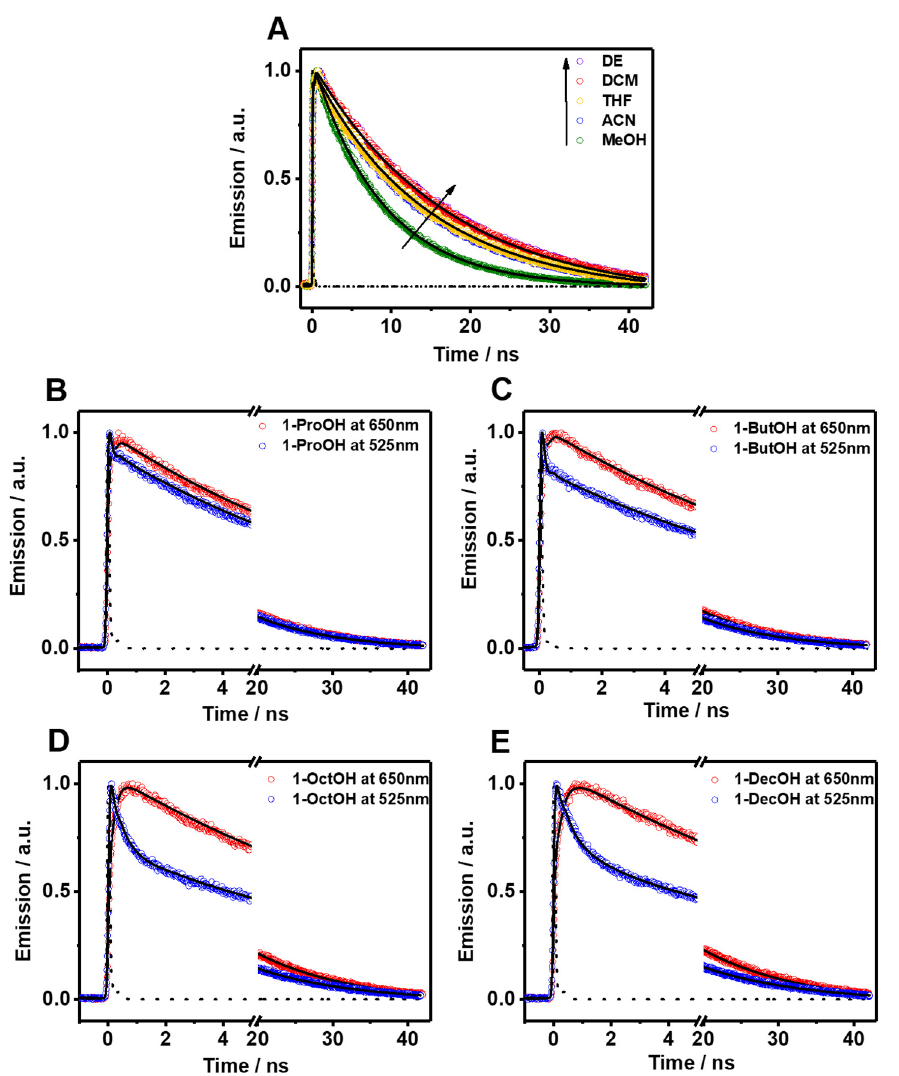
Figure 3. Magic-angle emission decays of Me 2 CANADC in ( A ) DE (purple circles), DCM (red circles), ACN (blue circles), MeOH (green circles), and THF (yellow line) upon 390 nm excitation and observed at 525 nm. Emission decays of Me 2 CANADC in 1-ProOH ( B ), 1-ButOH ( C ), 1-OctOH ( D ), and 1-DeOH ( E ) upon 390 nm excitation and observed at 650 nm (red circles) and 525 nm (blue circles). The solid black lines represent the best-fit using a mono or multiexponential model and the dashed black lines are the instrumental response function